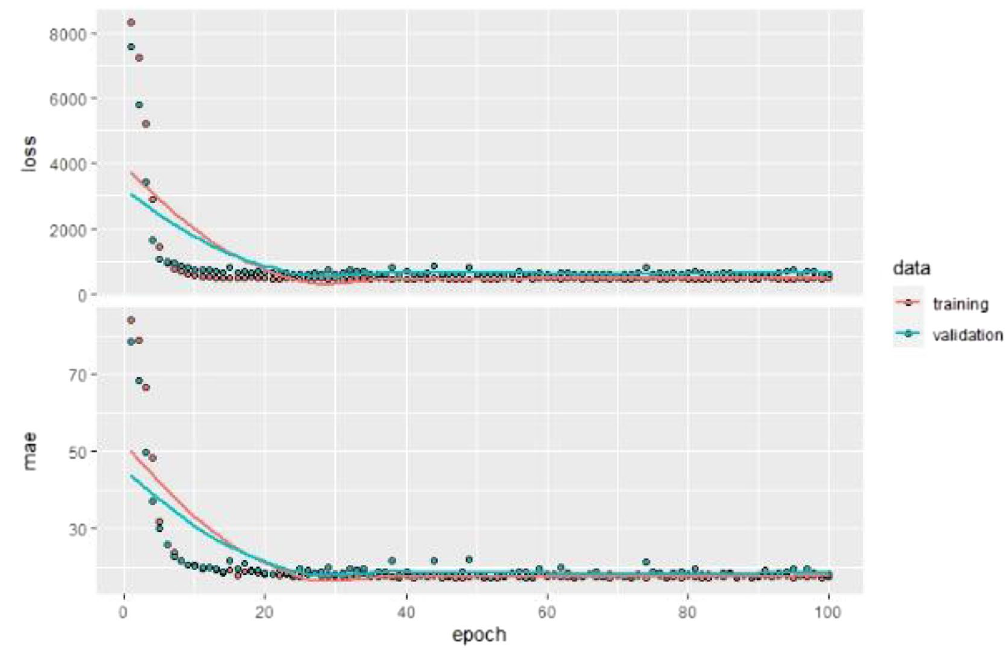
Figure 5. MSE and MAE as a function of the number of epochs.